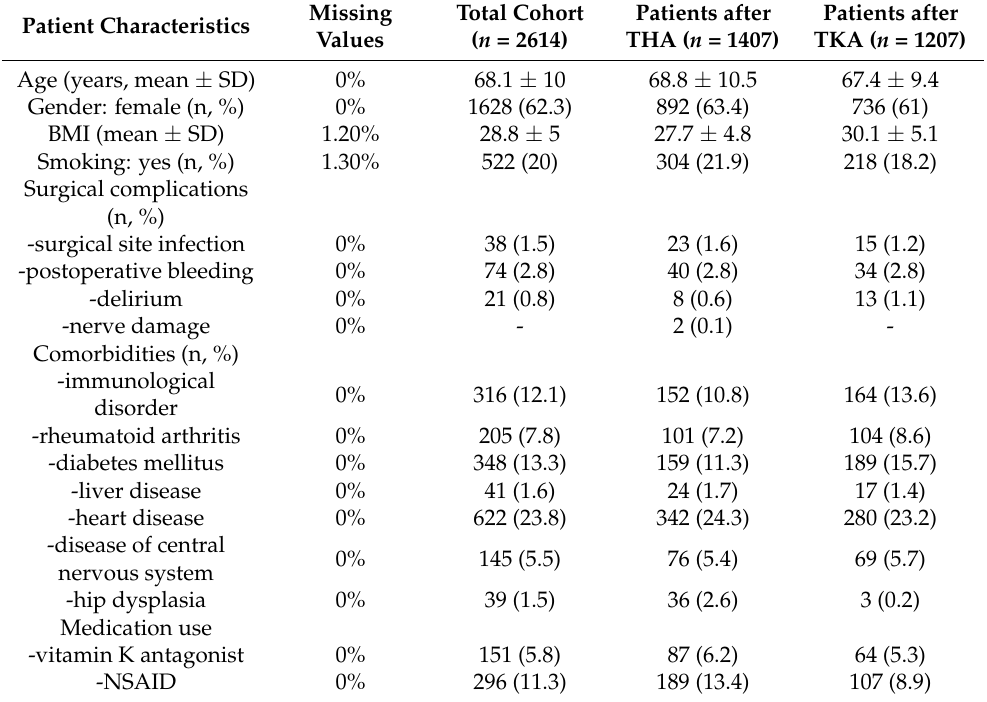
Table 1. Patient characteristics of study cohort.